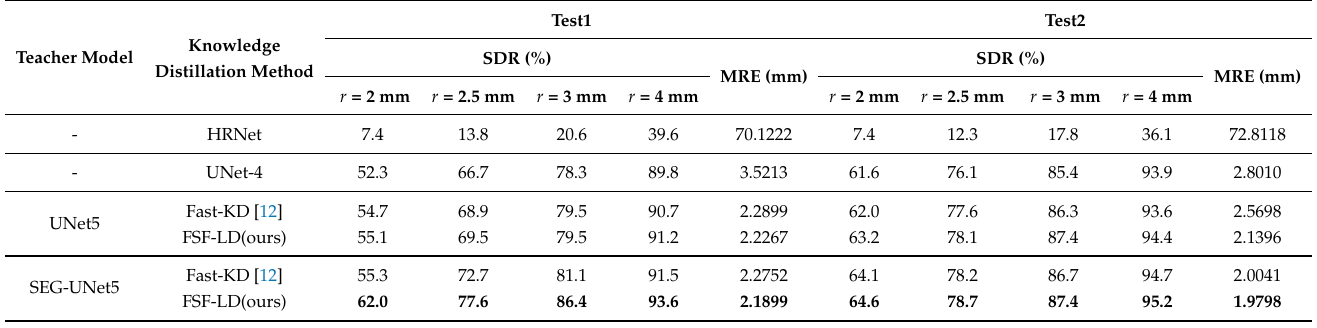
Table 6. 2D cephalometric radiograph dataset: The comparison results for our proposed KD method on the 2D cephalometric radiograph dataset. The student model is UNet4, while the teacher model is UNet5 and SEG-UNet5.